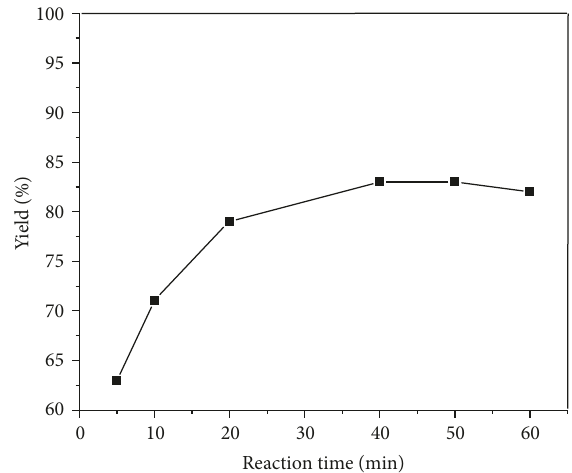
Figure 1: Effect of reaction time on reaction. Reaction conditions: CMDPA (25mmol), tetrahydrofuran 60 ml, [bmim]OH (2.5 mmol), CH 3 OH (40ml), 60 ∘ C. Isolated yield.